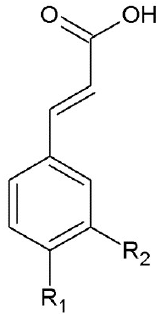
Figure 2. The structure of phenolic acids (R 1 =R 2 =H—cinnamic acid; R 1 =OH, R 2 =H— p -coumaric acid; R 1 =R 2 =OH—caffeic acid; R 1 =OH, R 2 =OCH 3 —ferulic acid).